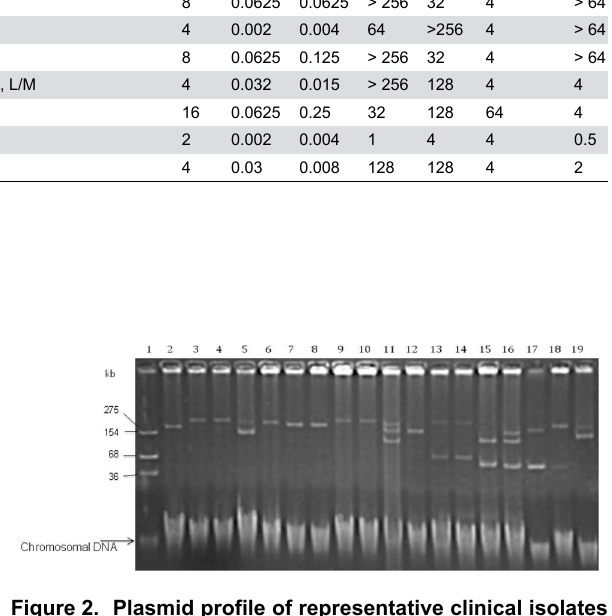
Figure 2. Plasmid profile of representative clinical isolates and transconjugants. 1. E. coli 50192 (154-, 68-, and 36-kb),